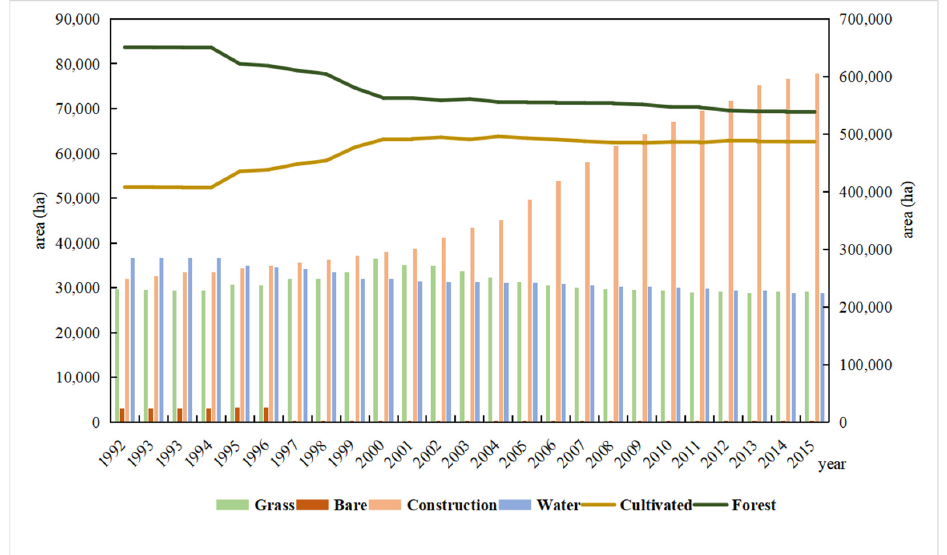
Figure 1. Changes of the forest land and cultivated land areas in Wenzhou City from 1992 to 2015 (left ordinate: grassland, bare land, construction land, and aquatic environments; right ordinate: forest land and cultivated land).